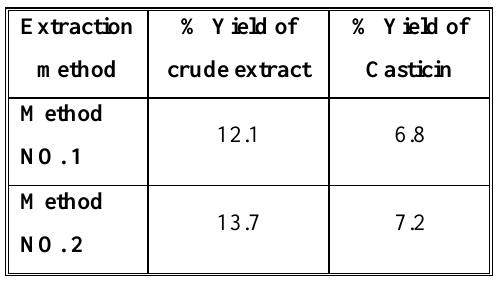
Figure 4: TLC of the fruit extract of Vitex agnus-castus L. obtained by extraction NO. 2 using silica gel GF 60 as adsorbent and (S2) as a mobile phase. (F= fruit extract, C= Casticin